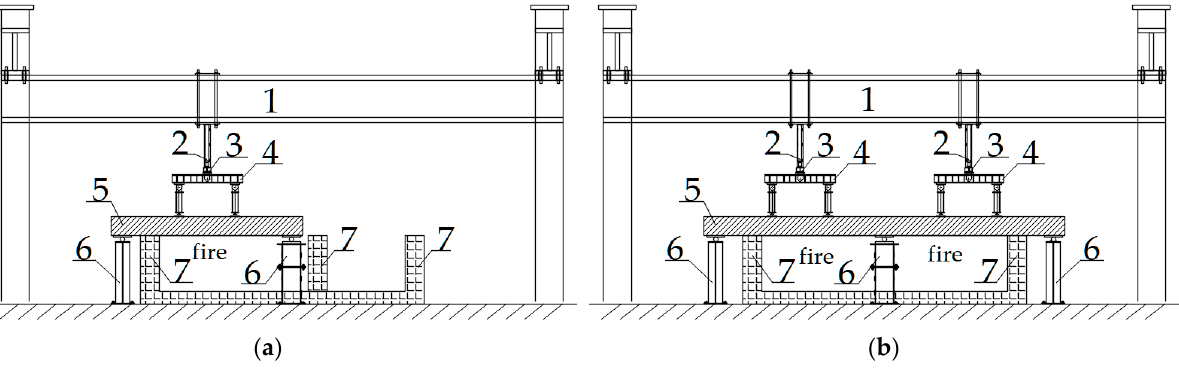
Figure 2. Test equipment: 1—longitudinal reaction steel beam; 2—hydraulic jack; 3—pressure sensor; 4—loading steel beam; 5—test beam; 6—steel bearing; 7—furnace wall; ( a )—continuous beam loading device ( b )—simply supported beam loading device.